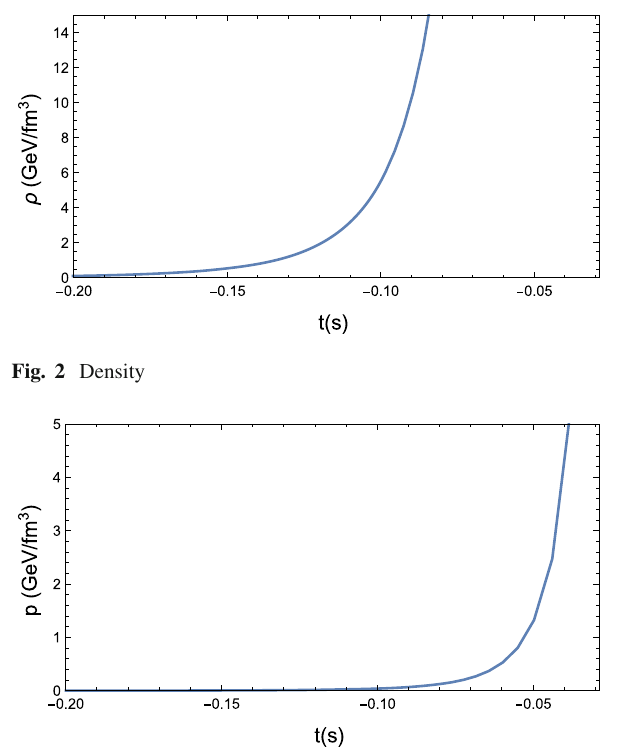
Fig. 3 Isotropic pressure at the co-moving boundary